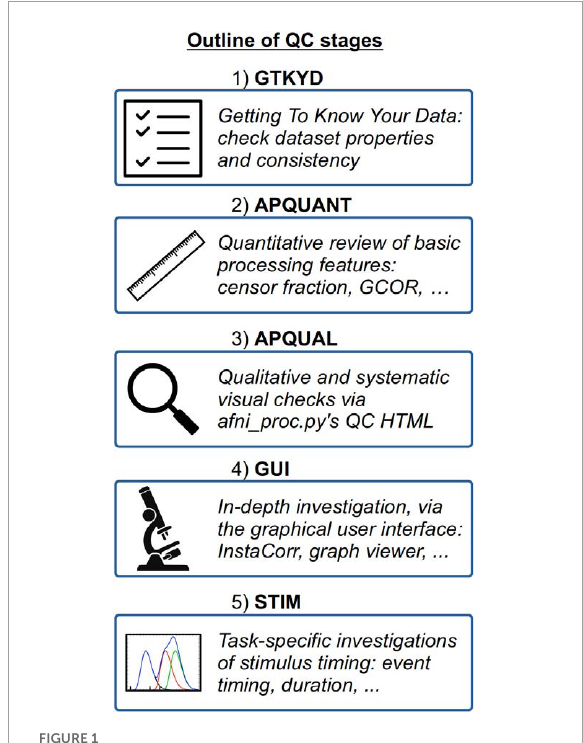
FIGURE1 An overview of the QC stages presented in the current